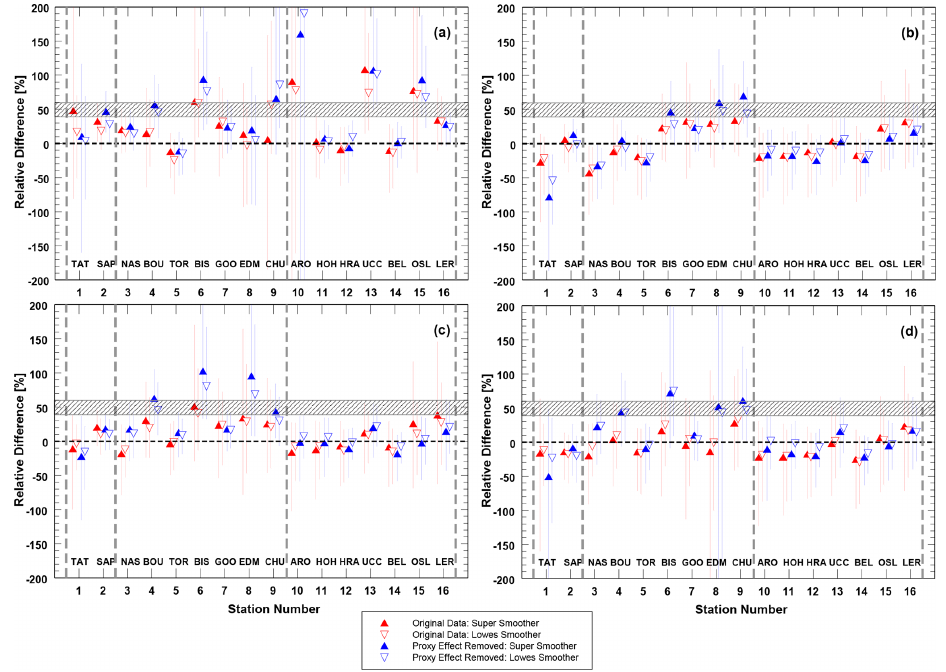
Figure A2. The same as Fig. A1 but for the ozone recovery index, ORI 2 (1997 ,